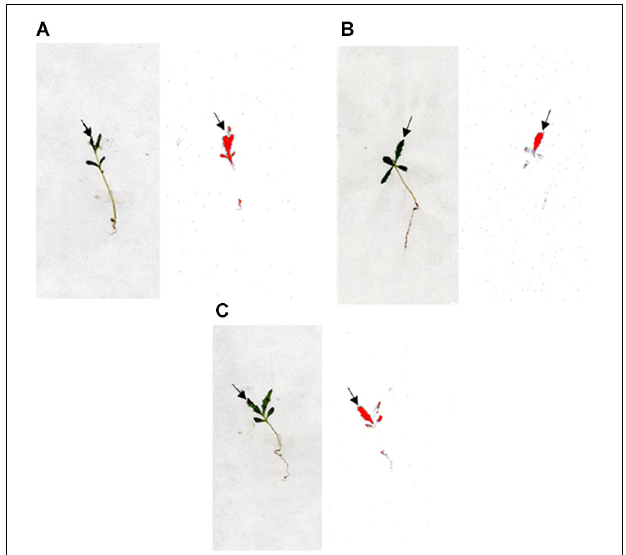
– FIGURE 3 | Digital photographs (plants on the left) and autoradiographic photographs of the phosphor imager (plants on the right) showing the distribution of 14 C-tribenuron within G. coronaria plants of population S, R1, and R2 ( A , B , and C , respectively) at 72 HAT. The highest concentration of 14 C is highlighted in red.